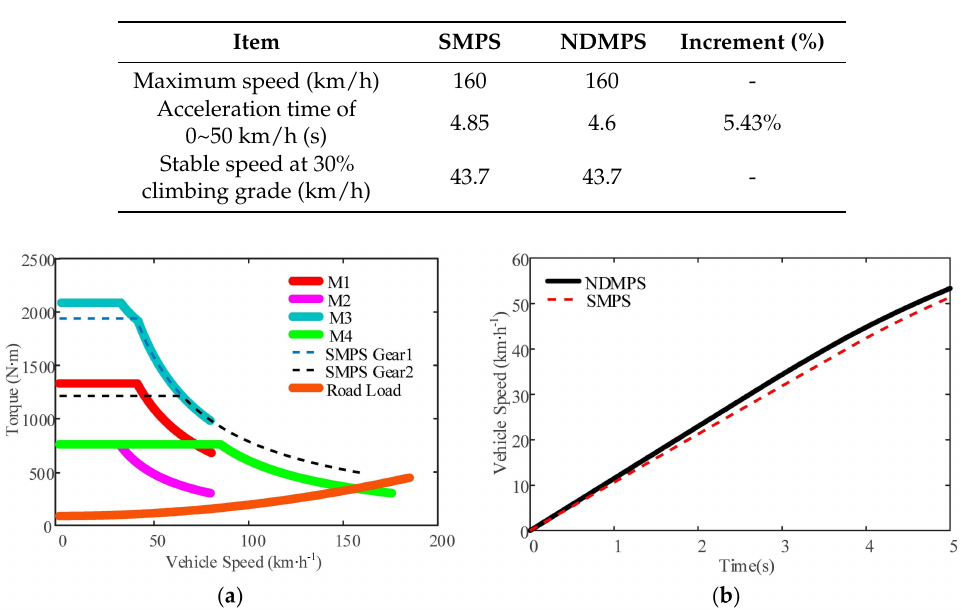
Table 6. Comparison of vehicle dynamic performance.